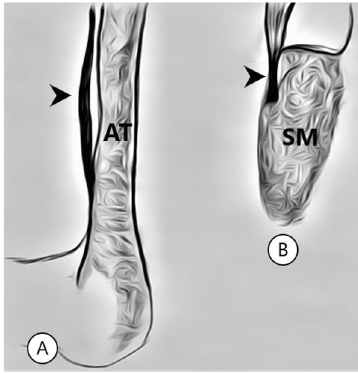
Figure 2. Types of tendon attachments. ( A ) type VII, ( B ) type VIII. AT Achilles tendon, Arrow plantaris tendon, SM soleus muscle.